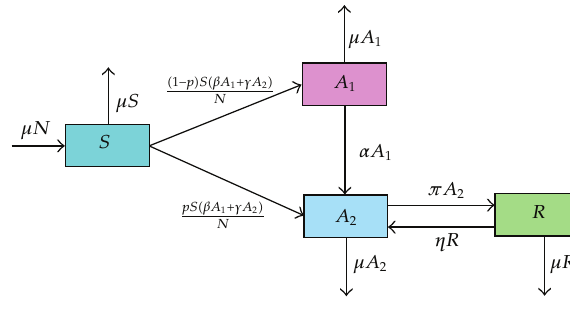
Figure 1: Transfer diagram of model (cid:4) 2.2 (cid:5)